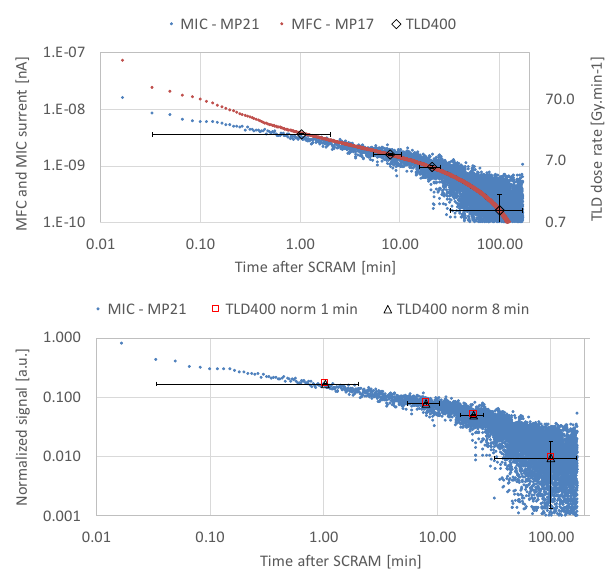
Fig. 4. Gamma and neutron signals decay after SCRAM. Top: MIC and MFC currents (left axis) compared to dose rates in the TLD400 (right axis). Bottom: comparison of the normalized MIC current and dose rates. Time uncertainties correspond to the time of dose integration for